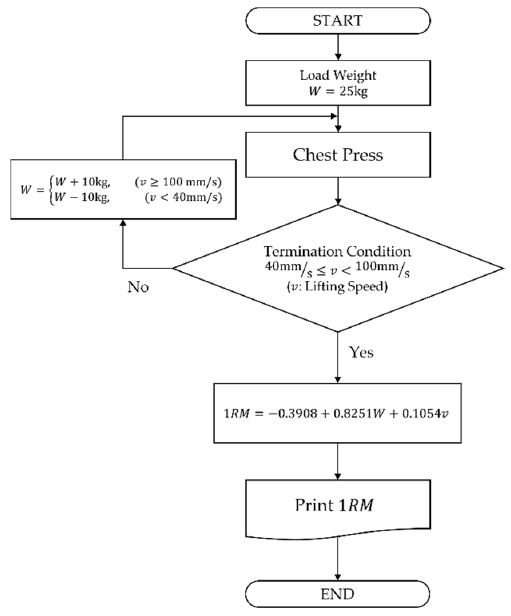
Figure 6. Simplified 1RM measurement algorithm using the hydraulic press machine.